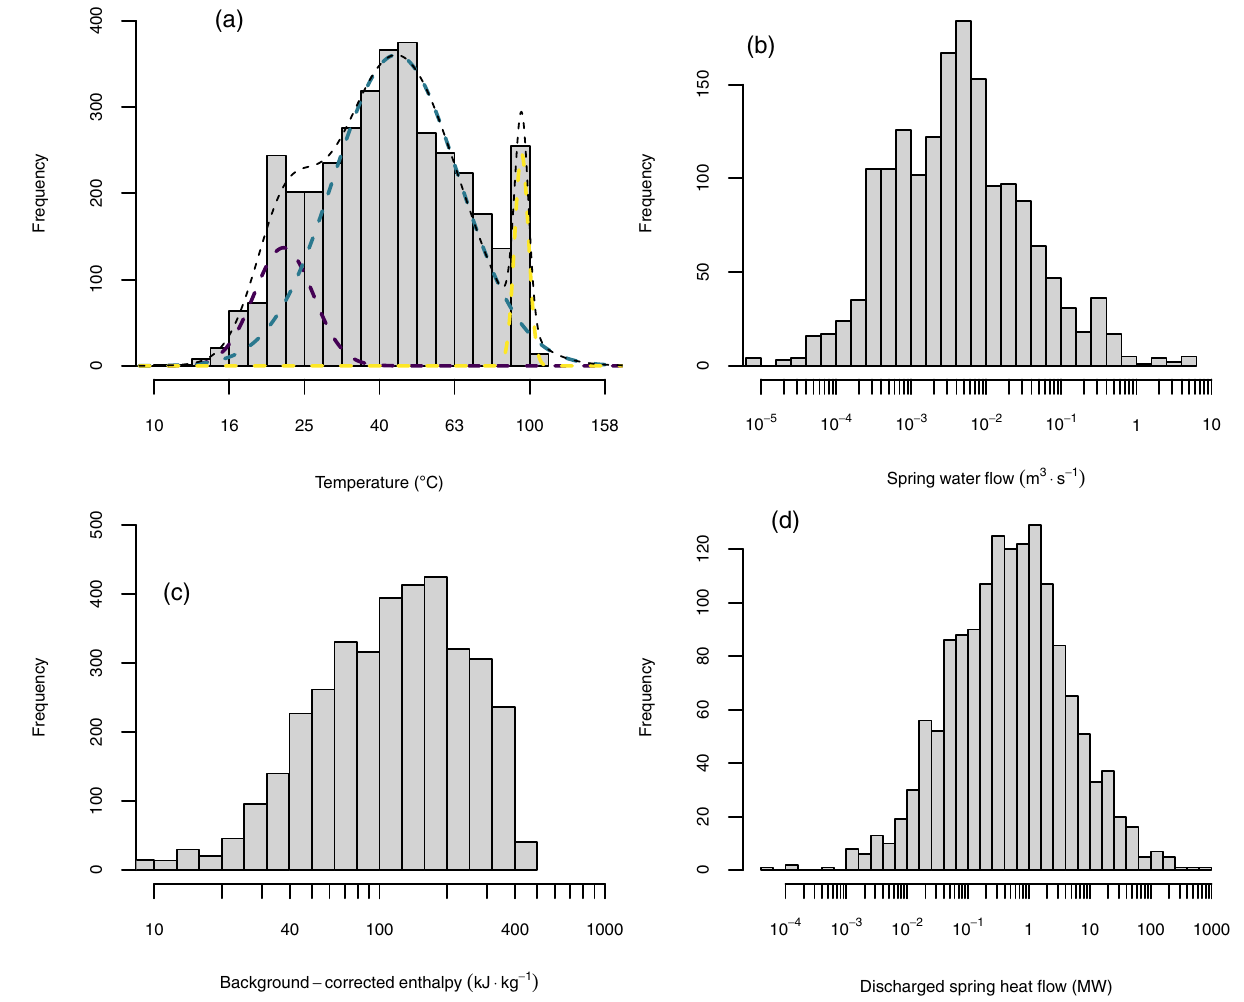
Fig. 2 | Thermal springs temperatures and enthalpies. Frequency histograms of ( a ) water spring temperature, ( b ) spring water fl ow, ( c ) calculated saturated liquid enthalpyand d dischargedheat.Themixofthreenormaldistributions,dashedlines